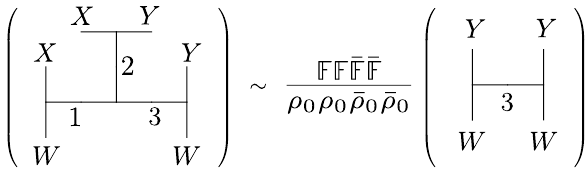
Figure 4 . The six-point OPE density associated with the channel on the left can be approximated by the four-point density on the right multiplied by a crossing kernel.